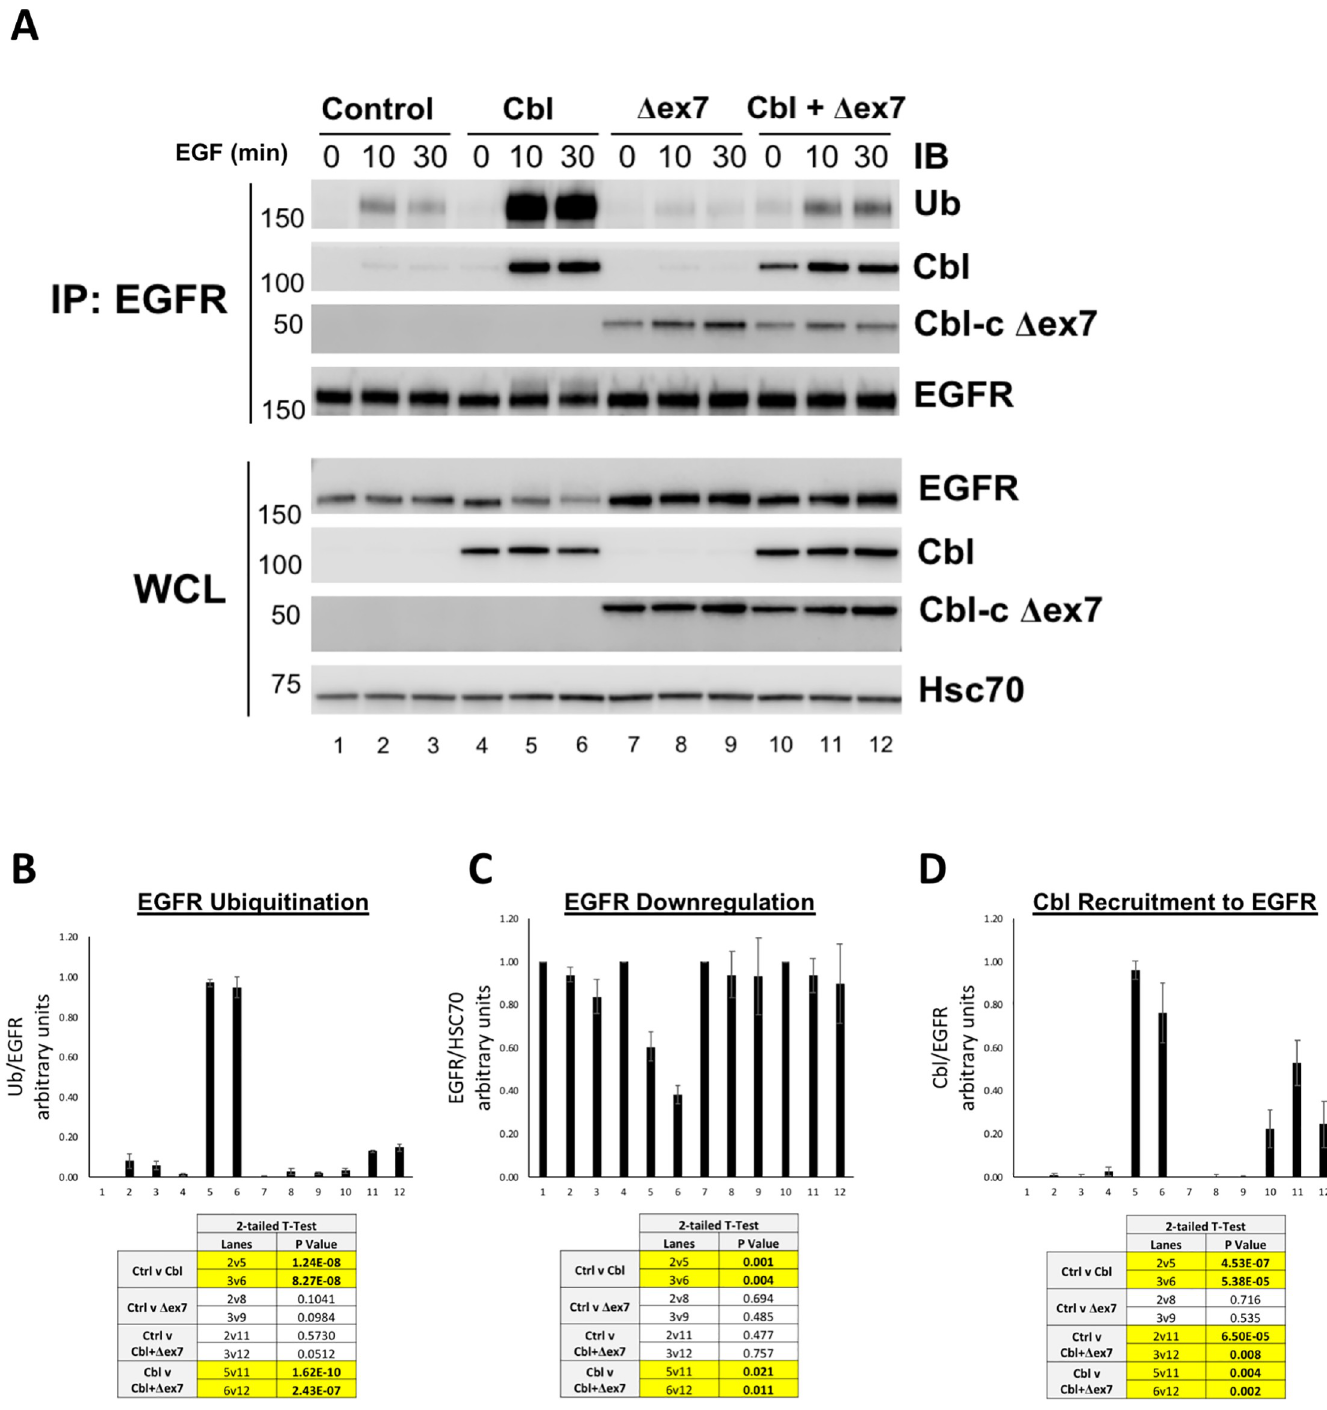
Fig 4. Murine mutant Cbl-c Δ ex7 prevents ubiquitination and downregulation of EGFR by WT Cbl proteins. ( A ) Cbl-c Δ ex7 prevents ubiquitination of EGFR by WT Cbl. HEK 293T cells were transfected with empty vector (Control), WT Cbl, Cbl-c Δ ex7, or a combination of WT Cbl and Cbl-c Δ ex7 as indicated. All cells were cotransfected with EGFR. Cells were stimulated with EGF for either 0, 10 or 30 minutes, harvested, and immunoprecipitated with anti-EGFR antibodies. The EGFR IP and WCL were probed for proteins as indicated. Molecular weight standards in kDa are indicated on the left of each panel. ( B ) EGFR-associated ubiquitin was quantified and normalized to total EGFR from the EGFR IP. ( C ) EGFR levels were quantified from the WCL and normalized to Hsc70. ( D ) EGFR-associated Cbl was quantified and normalized to total EGFR from the EGFR IP (Panel 2). Graphs represent the mean from 5 experiments +/- SE. p-values for relevant comparisons are shown in the tables accompanying the graphs. Significant comparisons (p � 0.05) are highlighted in yellow.